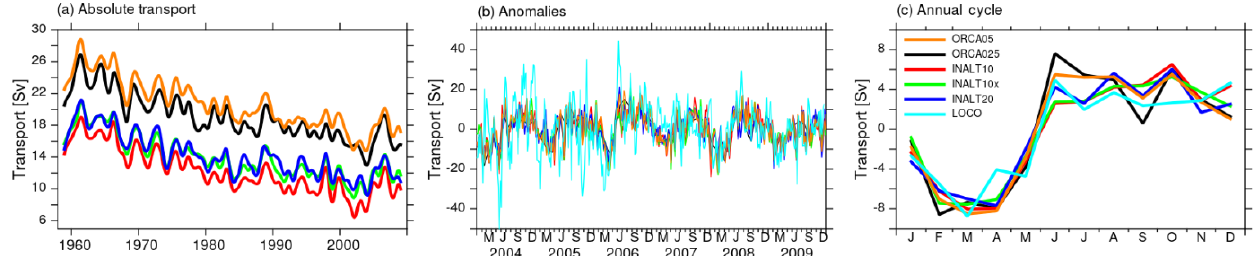
Figure 8. Time series of the southward barotropic transport through the Mozambique Channel (in Sv) as absolute values (a) and anomalies (b) compared to observations. The seasonal cycle of the anomalies for the period 2004 to 2009 is given in panel (c)